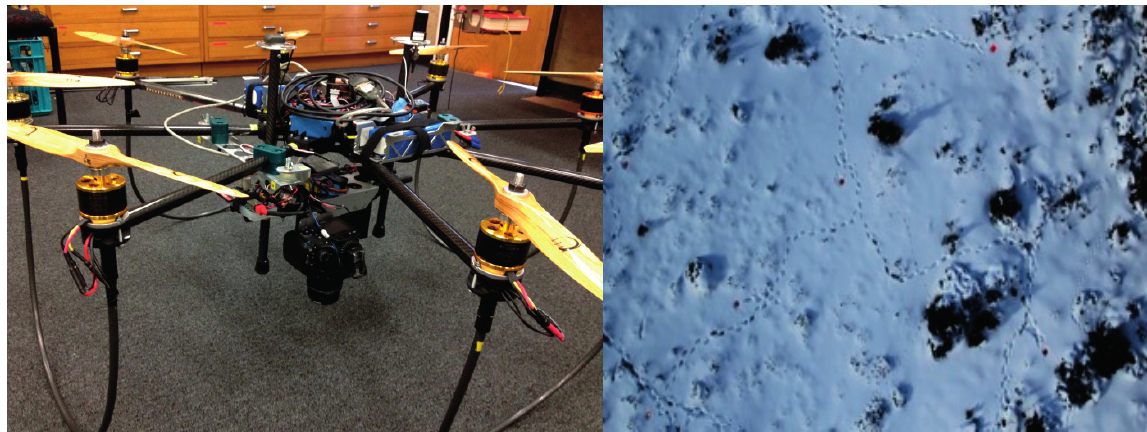
Figure 3. The UAS used in this study is shown ( left ); along with an example image ( right ) that was characteristic of our dataset. Footprints in the snow provide a sense of